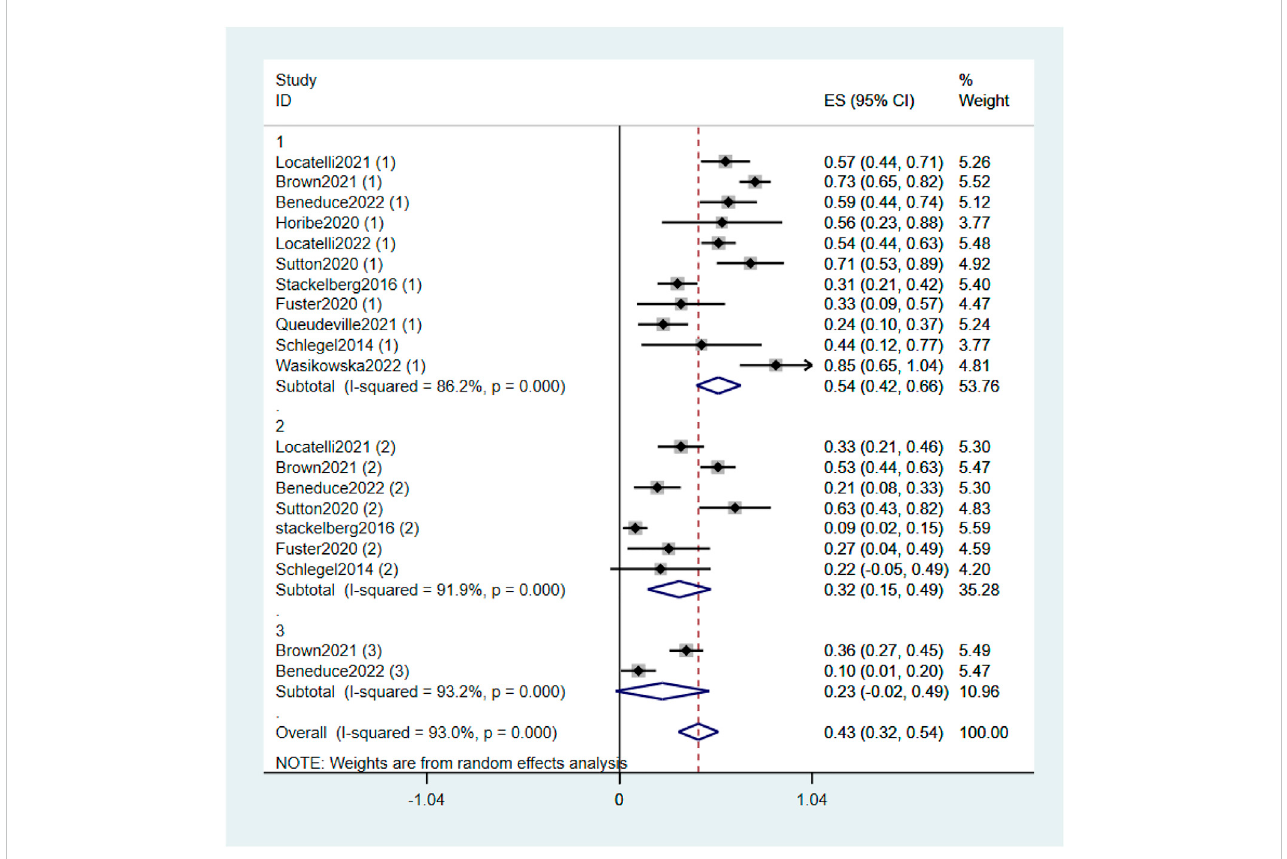
FIGURE 4 Forest plot of OS (single-arm studies). OS, overall survival; 95% CI, 95% con fi dence interval; ES: Effect Size; 1, 1-year; 2, 2-year; 3, 3-year. The size of the rectangle at the center of the horizontal bar is proportional to the weight of the given study. The diamond at the bottom indicates the pooled